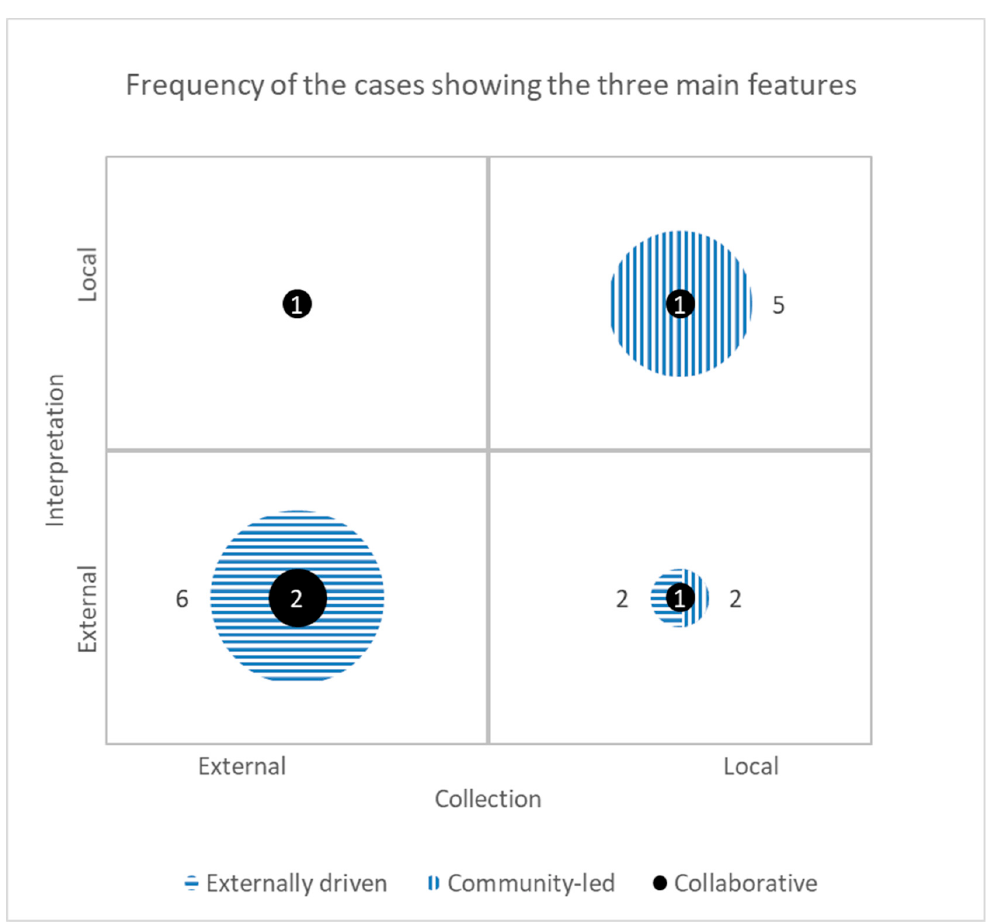
Figure 2. A summary of the number of PWM programs identified by collection approach ( X -axis) and interpretation type ( Y -axis) (N = 20) showing than no externally-led program considered local interpretation and that no community-led program considered external collection. The fill of the bubble identifies how the case was conceptualized: External (horizontal lines, number on the left of the bubble), collaborative (black, number at the center), or community led (vertical lines, number on the right). In the bottom-right quadrant, two cases were community-led and two cases were externally driven.